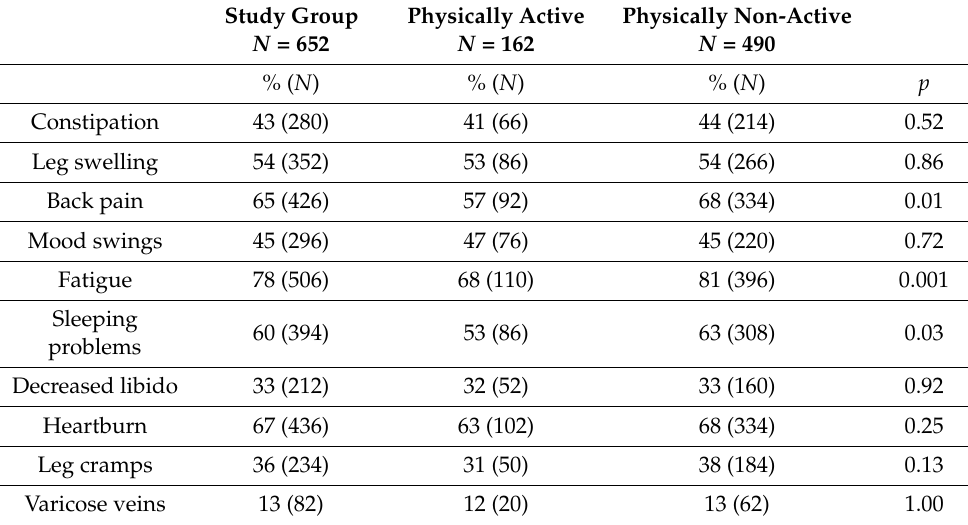
Table 2. Pregnancy ailments in the group of physically active and non-active